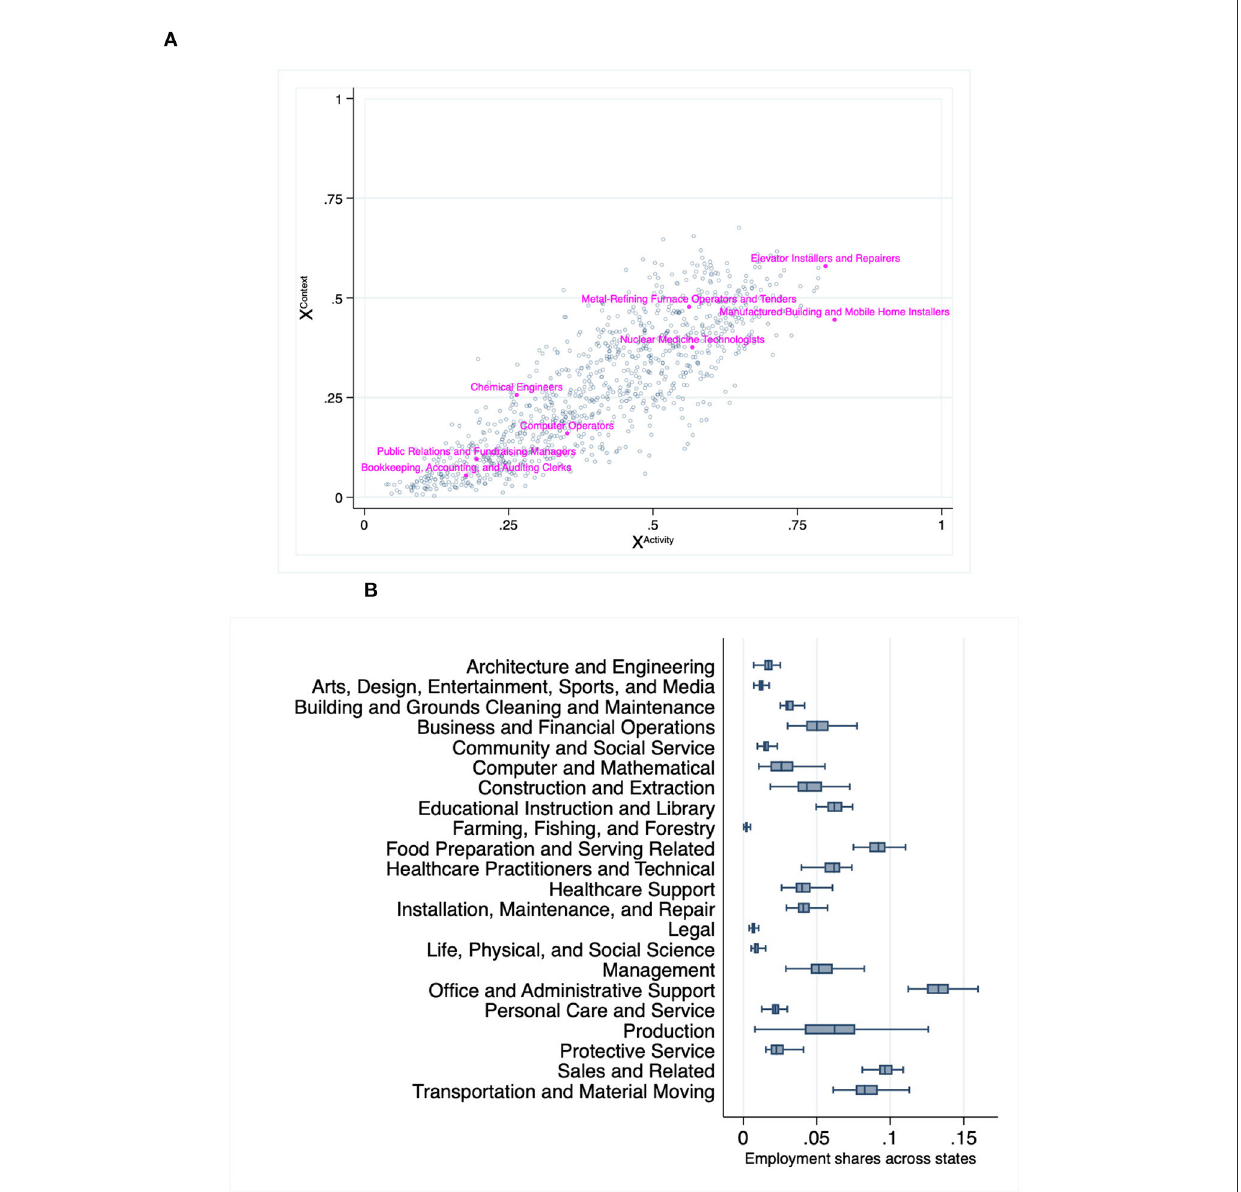
FIGURE2 Elements of State-level Teleworkability. (A) Occupations’ context and activity scores (lower scores reflect higher teleworkability). (B) Sectoral employment variability across states. (A) Data source: “Work Context” and “Work Activity” modules of the O*NET survey (https://www.onetonline. org/help/online/data). (B) Data source: BLS’ Occupational Employment Statistics Survey